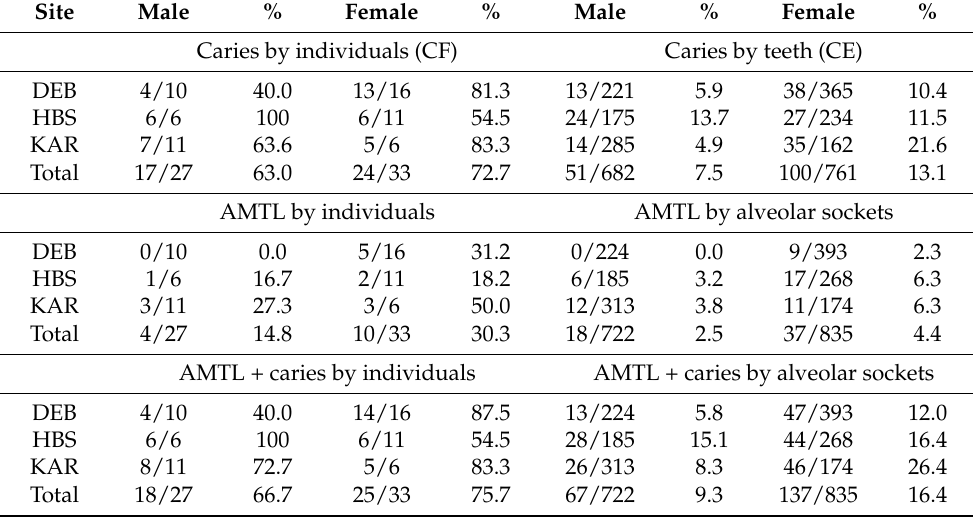
Table 4. Sex-specific differences in caries frequency (CF), caries experience (CE). Data on AMTL and AMTL combined with caries are given by individuals and assessable alveolar sockets.